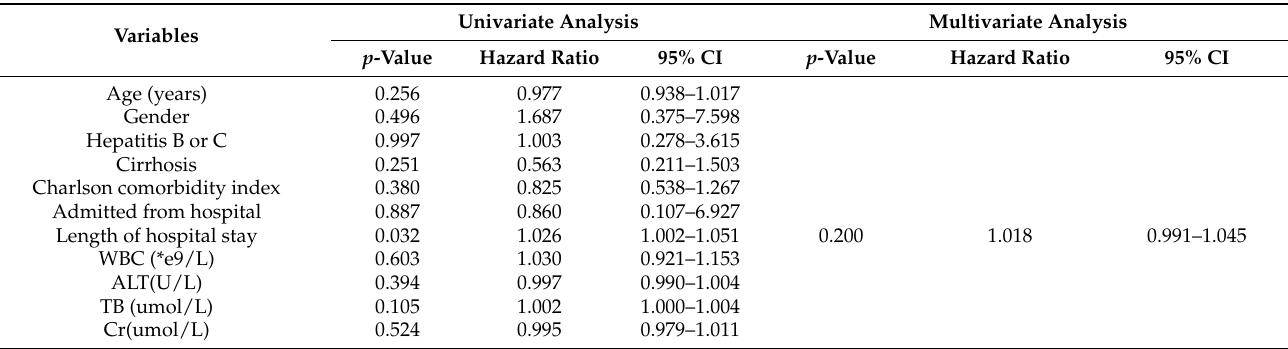
Table 2. Univariate and multivariate analysis of risk factors for CRE colonization in patients with